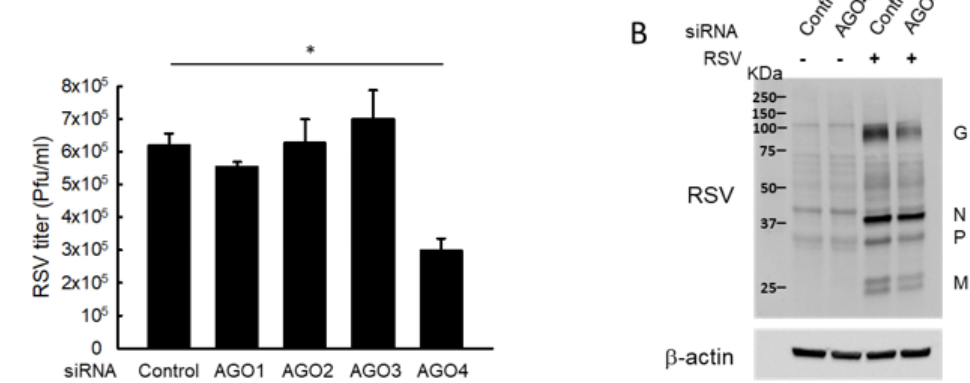
Figure 3. AGO4 knockdown reduces RSV replication. ( A ) A549 cells in triplicate were transfected with 100 nmol / L of siRNA against human AGO1, 2, 3, or 4, or scrambled siRNA (Control). At 24 h post-transfection, the cells were mock-infected or infected with RSV at MOI of 1 for 15 h and harvested for RSV titration assays. Data are representative of three independent experiments and expressed as means ± SE. * p < 0.05, relative to the control siRNA. ( B ) Cells, transfected with control or AGO4 siRNA, were infected with RSV and then harvested to prepare total cell lysates, followed by Western blot to check the expression of viral proteins using an anti-RSV antibody. β -actin was used as a control for equal loading of the samples. Data are representative of three independent experiments.